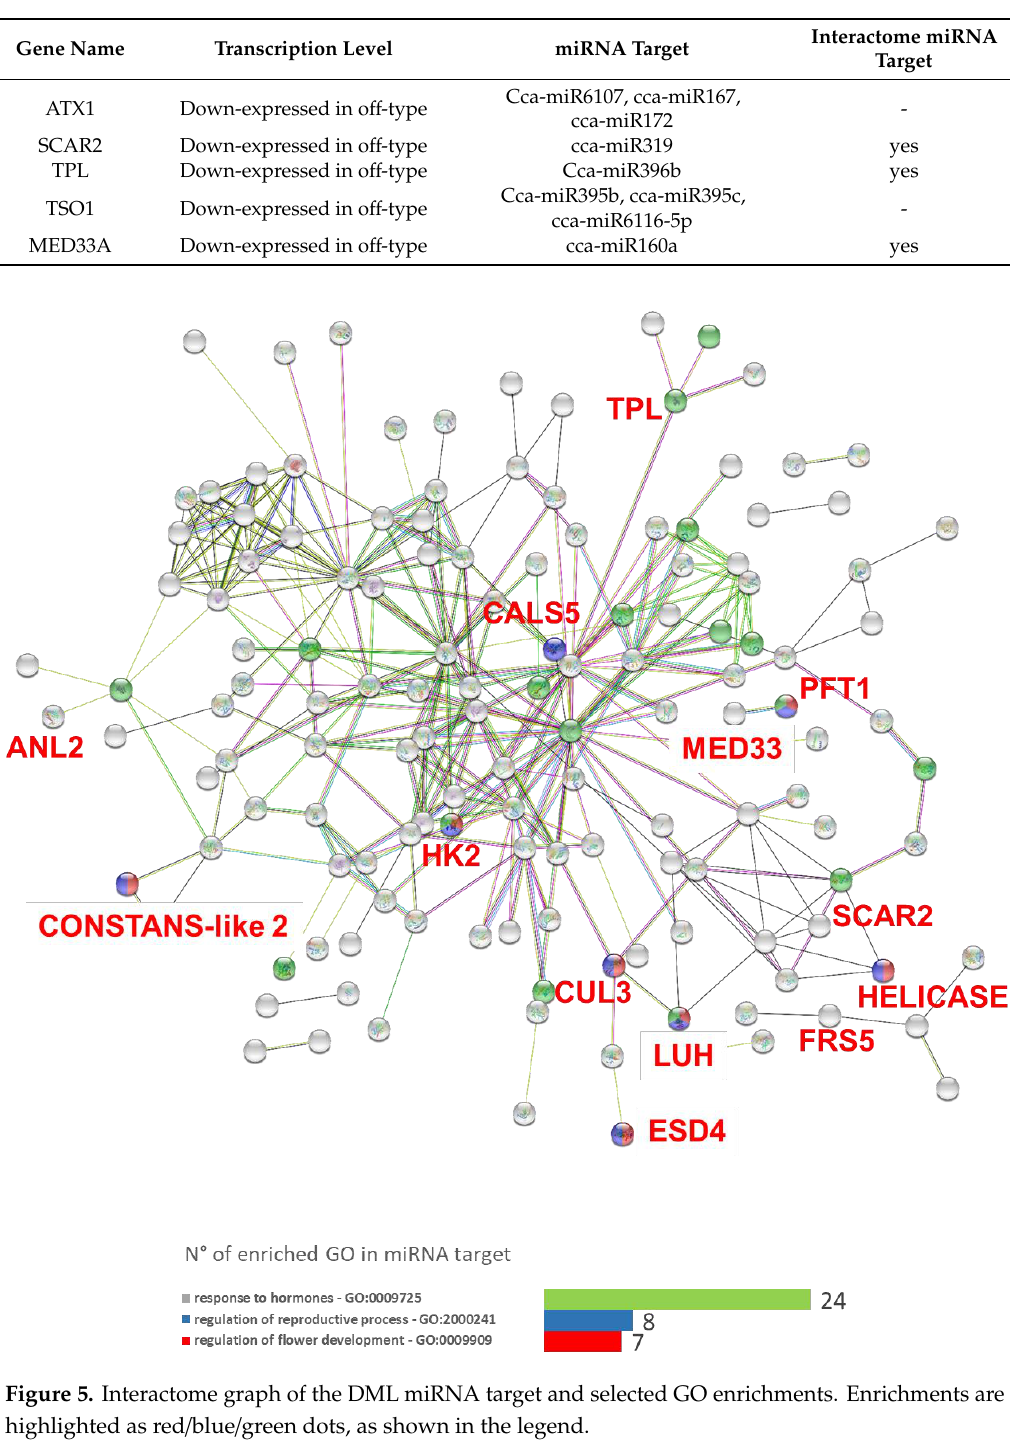
Table 2. Transcriptional and miRNA target analyses of a subset of di ff erentially methylated genes. For each gene transcription level, miRNAs and presence in the interactomic analysis are reported.